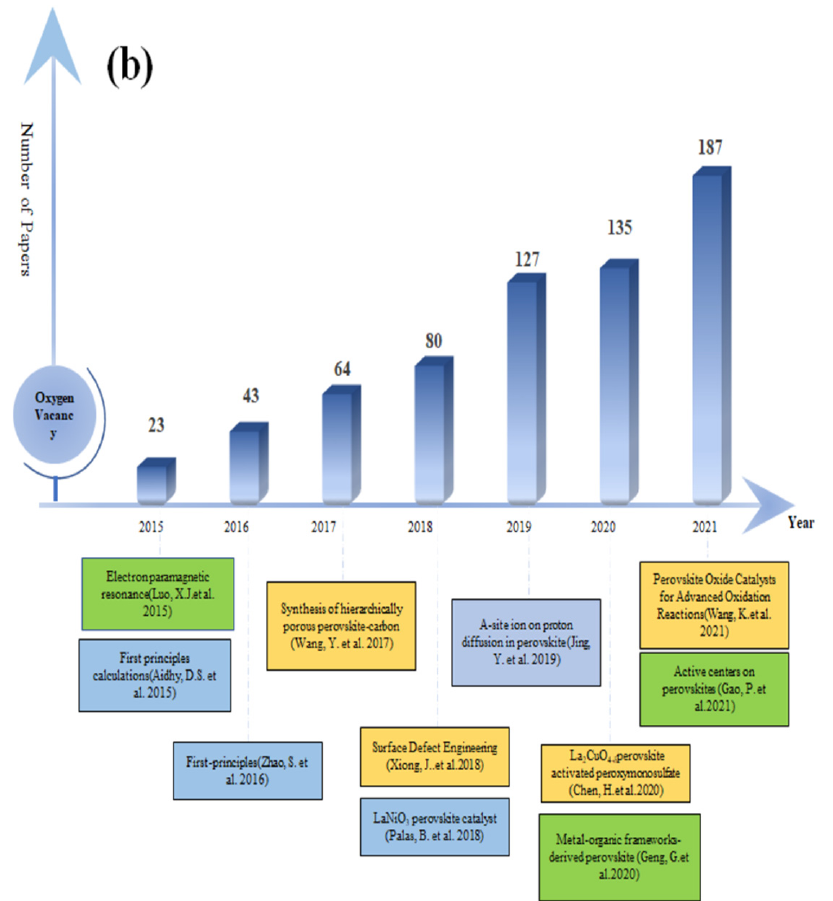
Figure 1. ( a ) Crystal structure of a cubic perovskite with a chemical formula of ABO 3 and ( b ) the number of papers abstracted by the database Web of Science for topic keywords “perovskite catalyst